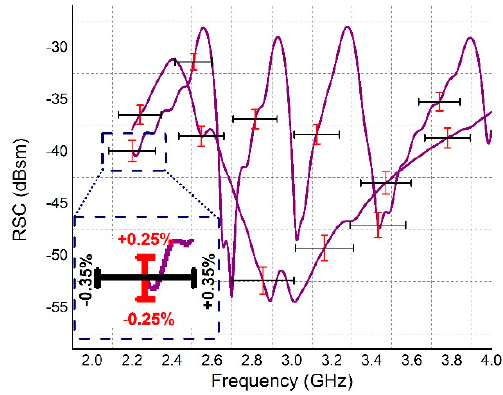
Figure 6. A schematic of test setup.